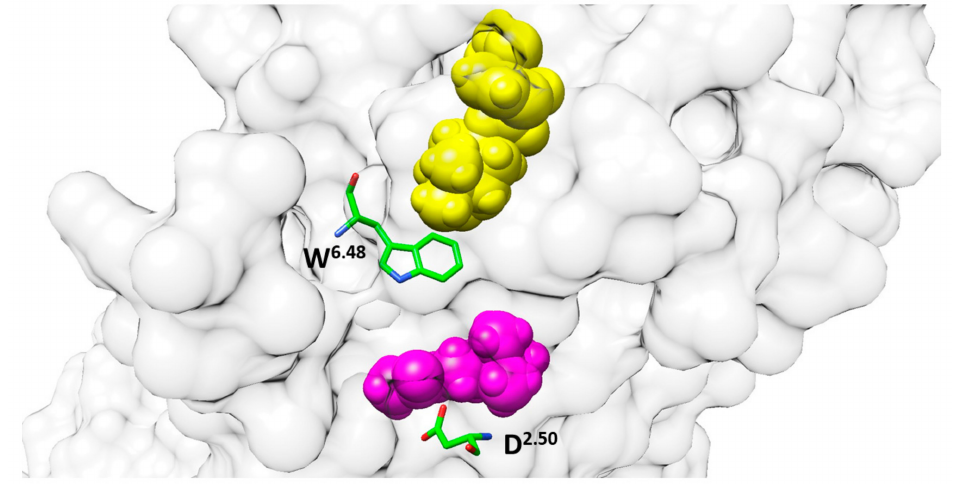
Figure 8. The M3 muscarinic receptor orthosteric binding site is near W 6.48 , whereas the new allosteric binding site is near D 2.50